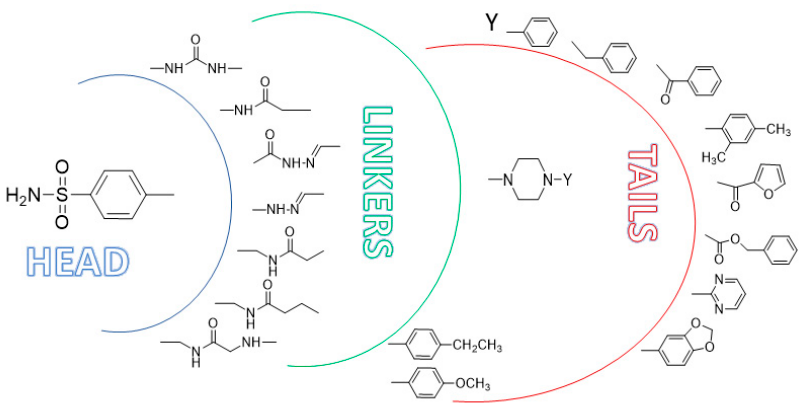
Figure 9. Graphical representation of CAIs